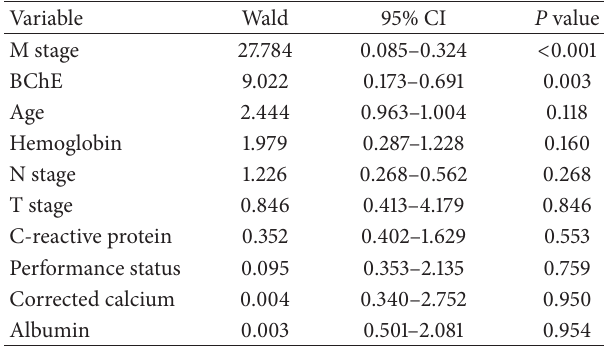
Table 3: Multivariate analysis in 400 patients with clear cell renal cell carcinoma.